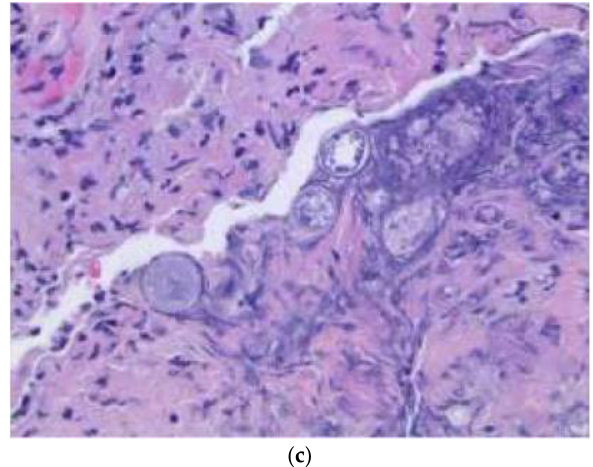
Figure 3. ( a ) Sagittal T1-weighted MR images with contrast showing extensive disc space destruction at C3-4 with epidural enhancement. ( b ) Sagittal cervical spine CT showing postoperative erosion of the C4 vertebral body significant retrolisthesis of C3 onto C4. ( c ) H&E stain of the cervical spinal pathologic specimen demonstrating the Coccidioides spherules within soft tissue, which is morphologically compatible with coccidioidomycotic osteomyelitis.